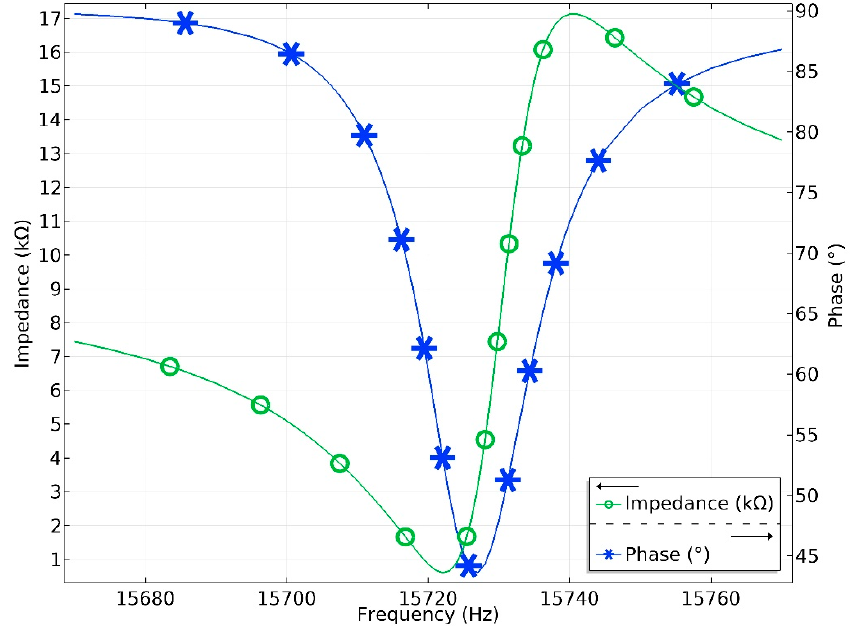
Figure 6. Impedance and phase frequency characteristics of the motor.